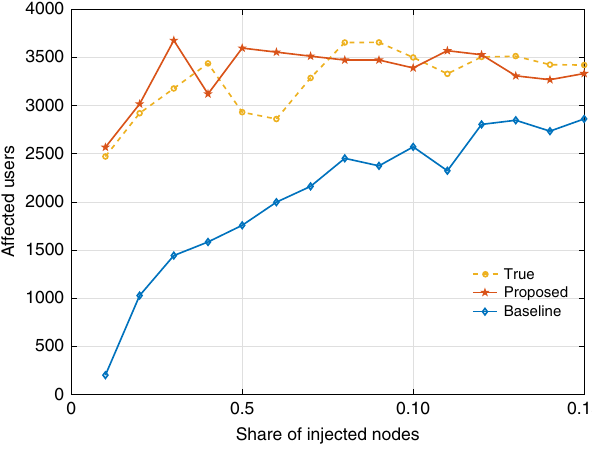
Fig. 7 Comparison of capability to estimate affected users ( α =